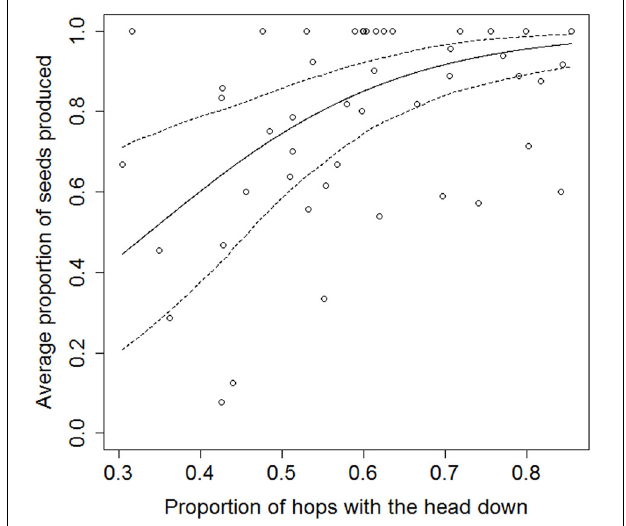
FIGURE 1 | Influence of the proportion of hops with head down on the proportion of seeds produced (regression line and 95%CI). Each individual is represented twice by its averaged values in each